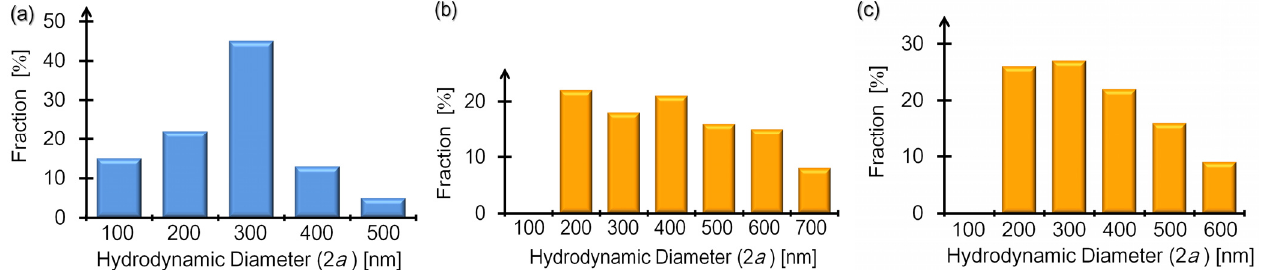
Figure 4. Histogram representations of diameter distributions regarding polycation-deposited SBs (NM-SBs ( a ) and PM-SBs ( b )) and polyanion-polycation-deposited SBs (ND-SBs ( c )). Both of the transverse and longitudinal axes denoted the same as those of Figure 1b where the distribution of bare SBs has been